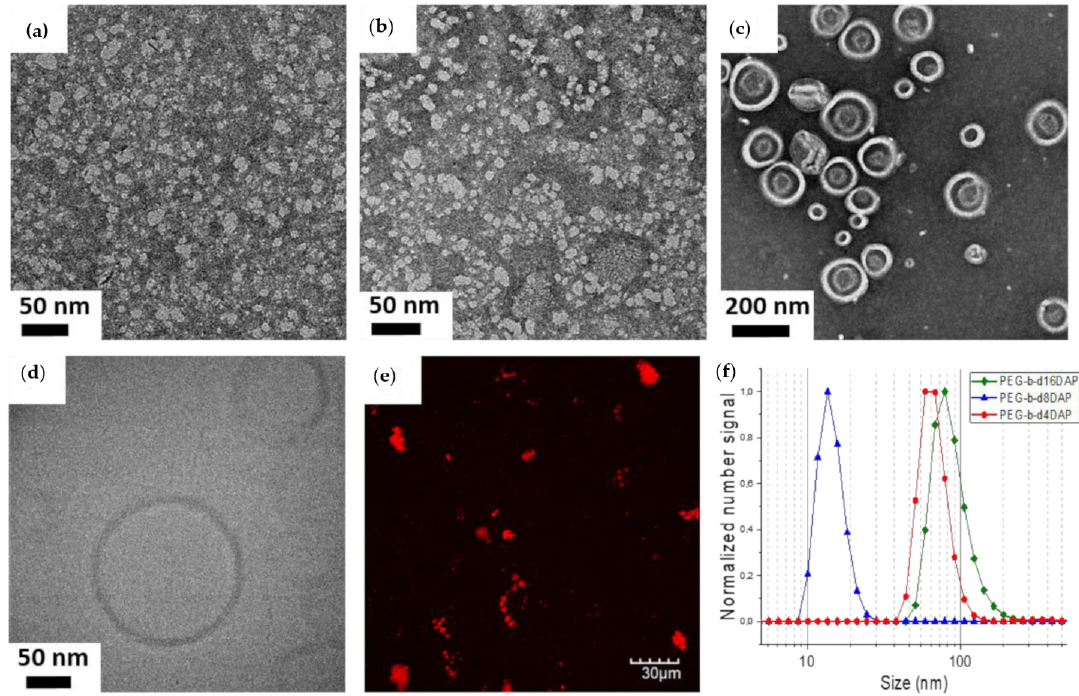
Figure 1. TEM images of ( a ) PEG 2k - b -d4DAP , ( b ) PEG 2k - b -d8DAP , and ( c ) PEG 2k - b -d16DAP self-assemblies prepared by nanoprecipitation. ( d ) Cryogenic Transmission Electron Microscopy (Cryo-TEM) image of PEG 2k - b -d16DAP vesicles. ( e ) Fluorescence microscopy image of the water suspension of PEG 2k - b -d16DAP vesicles with encapsulated Rhodamine B. ( f ) Number particle size distributions recorded by Dynamic Light Scattering (DLS) of LDBCs self-assemblies prepared by